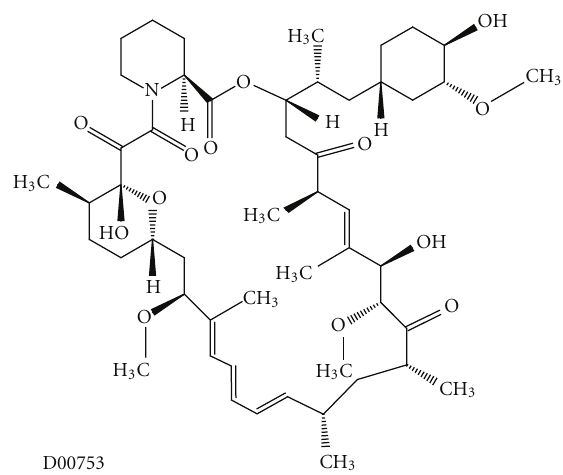
Figure 8: Molecular structure of sirolimus extracted from KEGG database